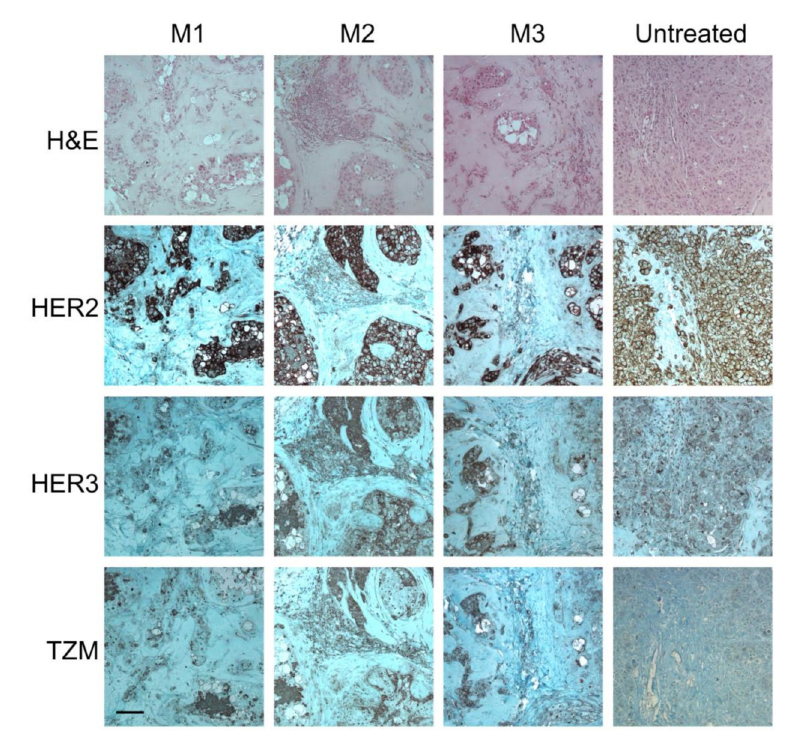
Figure 7. IHC ex vivo validation confirms TZM accumulation in the cancer cells both positive for HER2 and HER3. Consecutive sections of tumors M1–M3 and tumor from untreated mouse were processed for H&E staining, anti-HER2, anti-HER3, and anti-TZM immunohistochemical staining. NovaRED was used as peroxidase substrate (brown stain), tissue was counterstained with methyl green. Scale bar = 100 µ